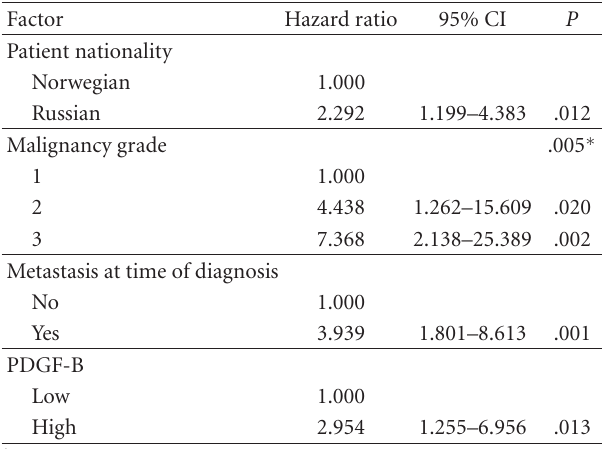
∗ Overall significance as a prognostic factor. Abbreviations: PDGF: platelet- derived growth